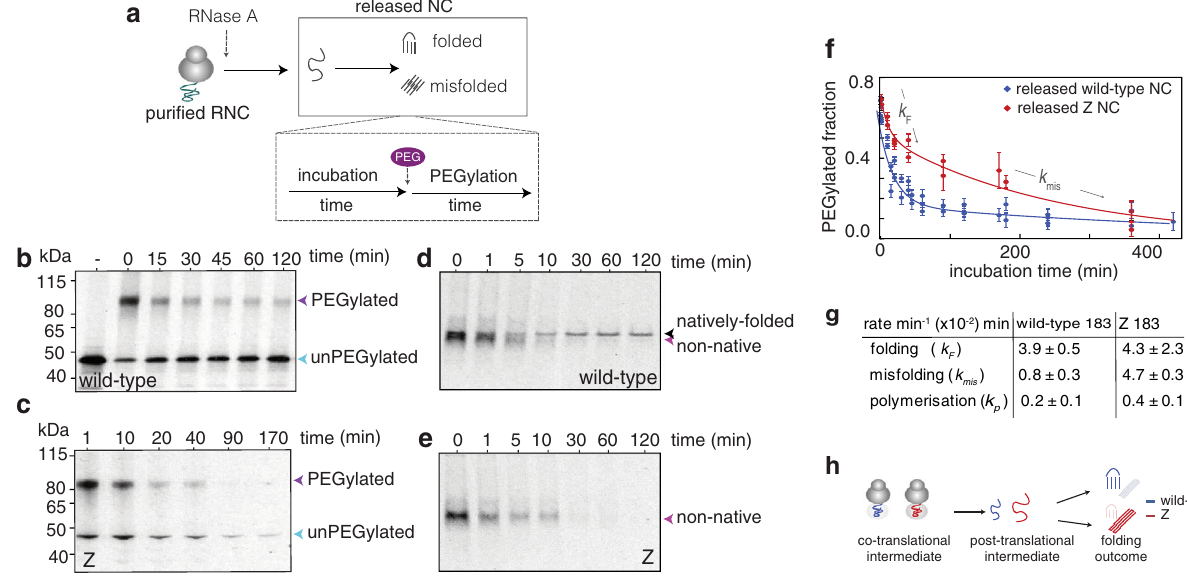
Fig. 7 Monitoring post-translational folding outcomes of released AAT nascent chains (NC). a A reaction scheme for monitoring post-translational folding by PEGylation, in which nascent chains are synchronously-released from 183C RNCs using RNase A to initiate their (off the ribosome) folding. PEG is added at intervals to monitor the folding process, and the PEGylation reaction time is 60 min at 25 °C. ( n = 5 biological repeats). b PEGylation of RNase A-released nascent chains of wild-type 183C monitored via partially-denaturing PAGE. c As described for b , but shows Z 183C. d Folding of RNase A- released, wild-type nascent chains as monitored by native PAGE (equivalent samples as shown in (b), but without PEGylation). e Folding of RNaseA- released, Z nascent chains as monitored by native PAGE (equivalent samples as shown in c , but without PEGylation). f A PEGylation pro fi le for RNAse A-released wild-type and Z 183C nascent chains from their respective RNCs (analysis of b , c , respectively). Data are presented as mean values + / − SEM. g Rates of post-translational folding, misfolding and polymerisation of RNase A-released 183C nascent chains ( n = 4 biological repeats). h A schematic illustrating the tempering effect imposed by ribosome on emerging nascent chains which is removed after the nascent chains are released. All PAGE used 35 S methionine